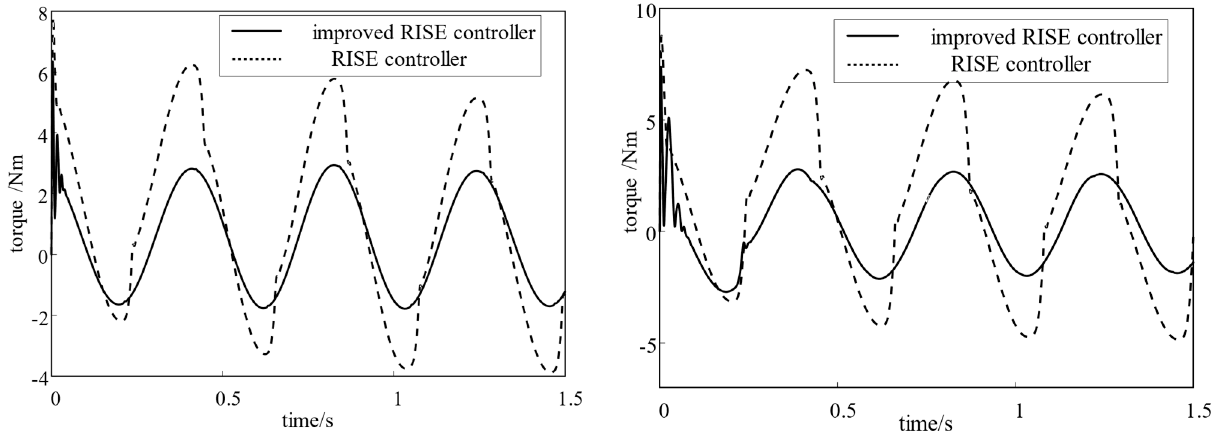
Figure 12. Loading torque tracking error curve after adding backlash compensator and speed synchronization controller.